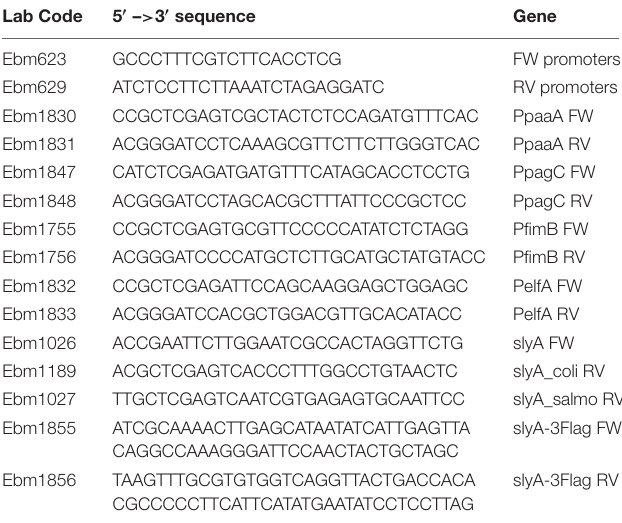
TABLE 2 | Oligonucleotides. Lab Code